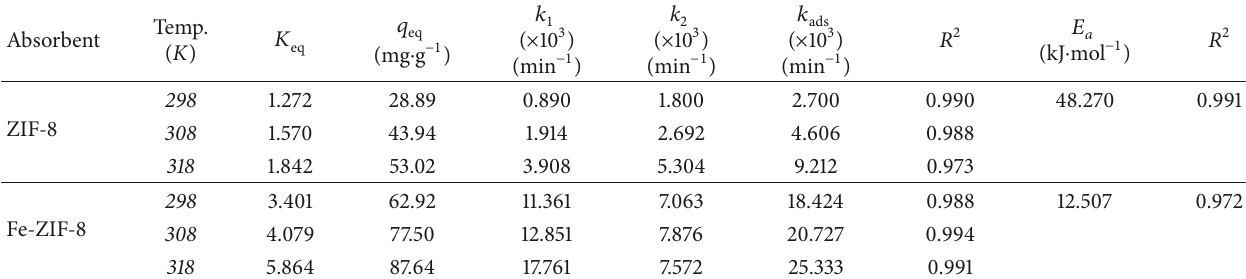
Table 7: Activation parameters for RDB dye adsorption onto ZIF-8 and Fe-ZIF-8.